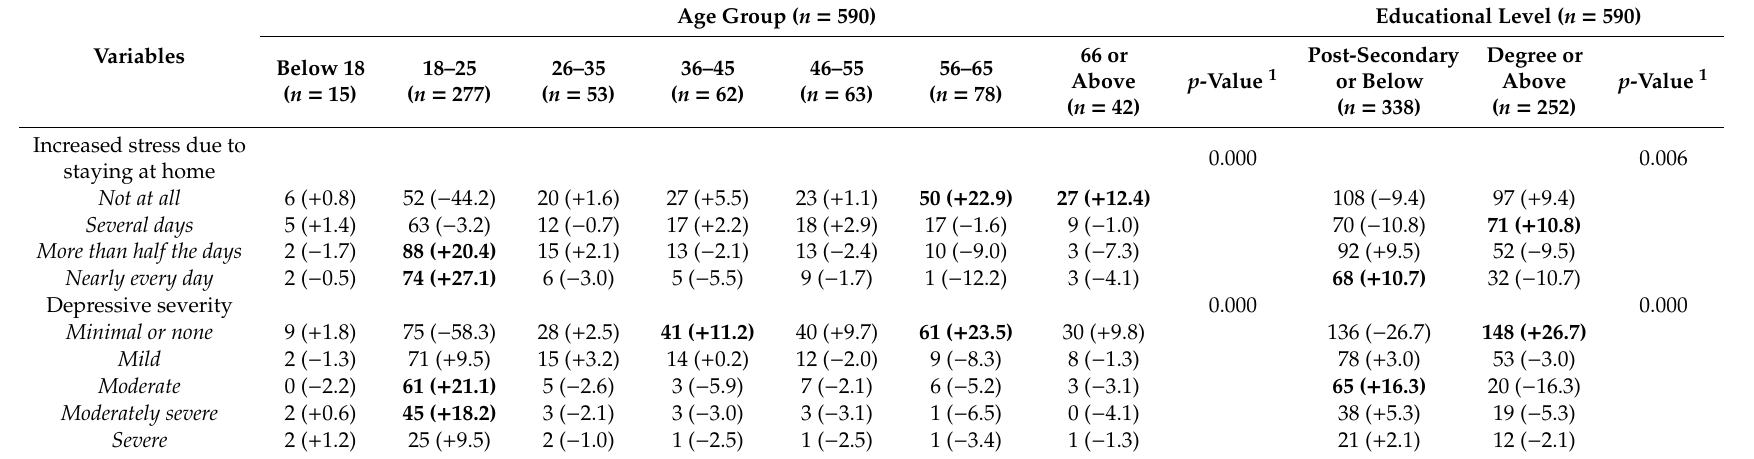
Table 5. Relationship of mental severity and demographic